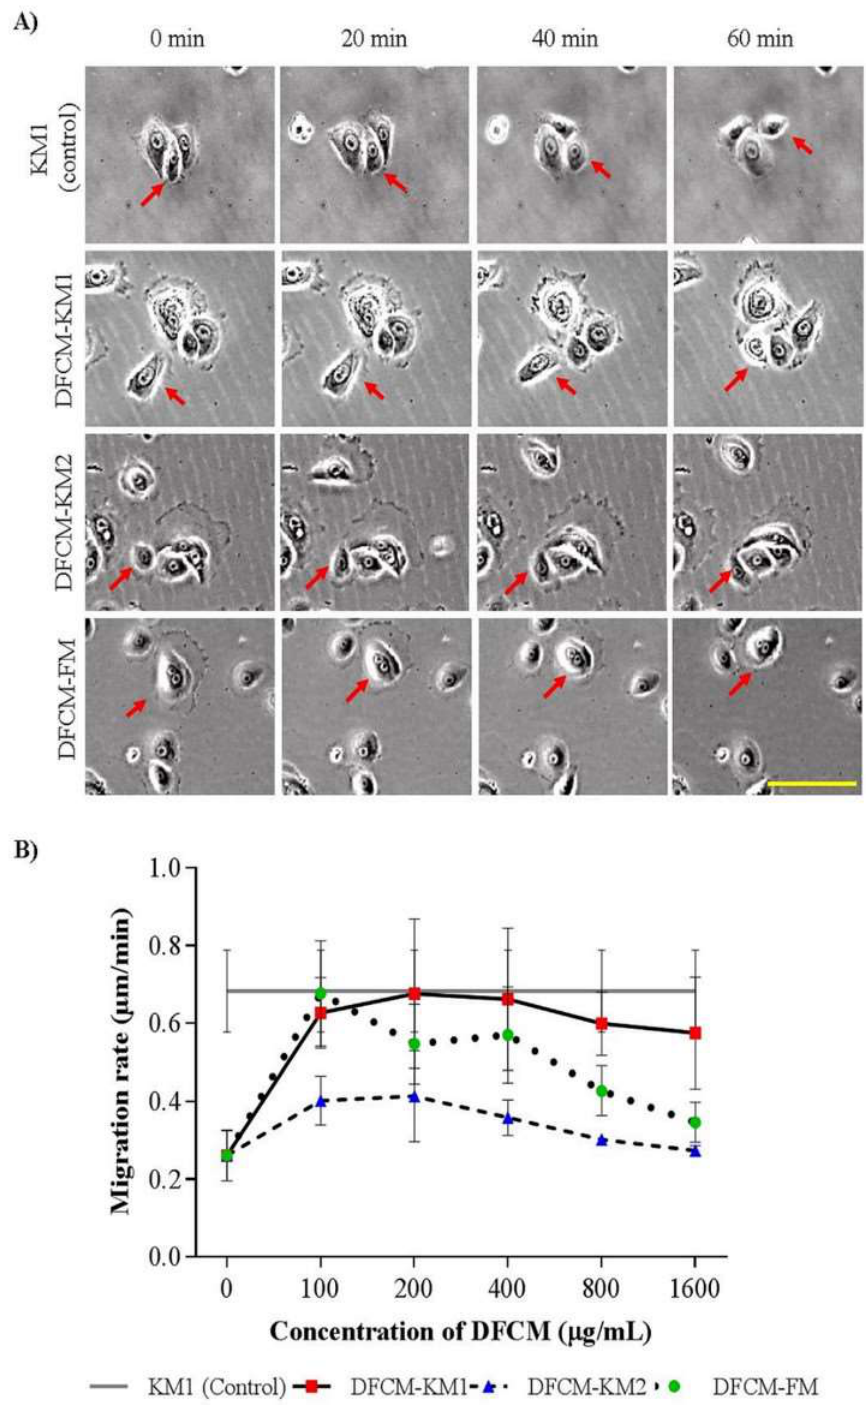
Figure 3. The e ff ect of DFCM on keratinocyte migration at subconfluent state. ( A ) The images of keratinocyte migration supplemented with 100 µ g / mL DFCM. Arrow indicates cell movement. Scale bar is 100 µ m. ( B ) Keratinocyte migration rate. No concentration-dependent e ff ect was observed in the DFCM-KM1 and DFCM-KM2 groups; DFCM-FM group showed a decreasing trend with increased DFCM-FM concentration. ( n = 3). Scale bar = 100 µ m.